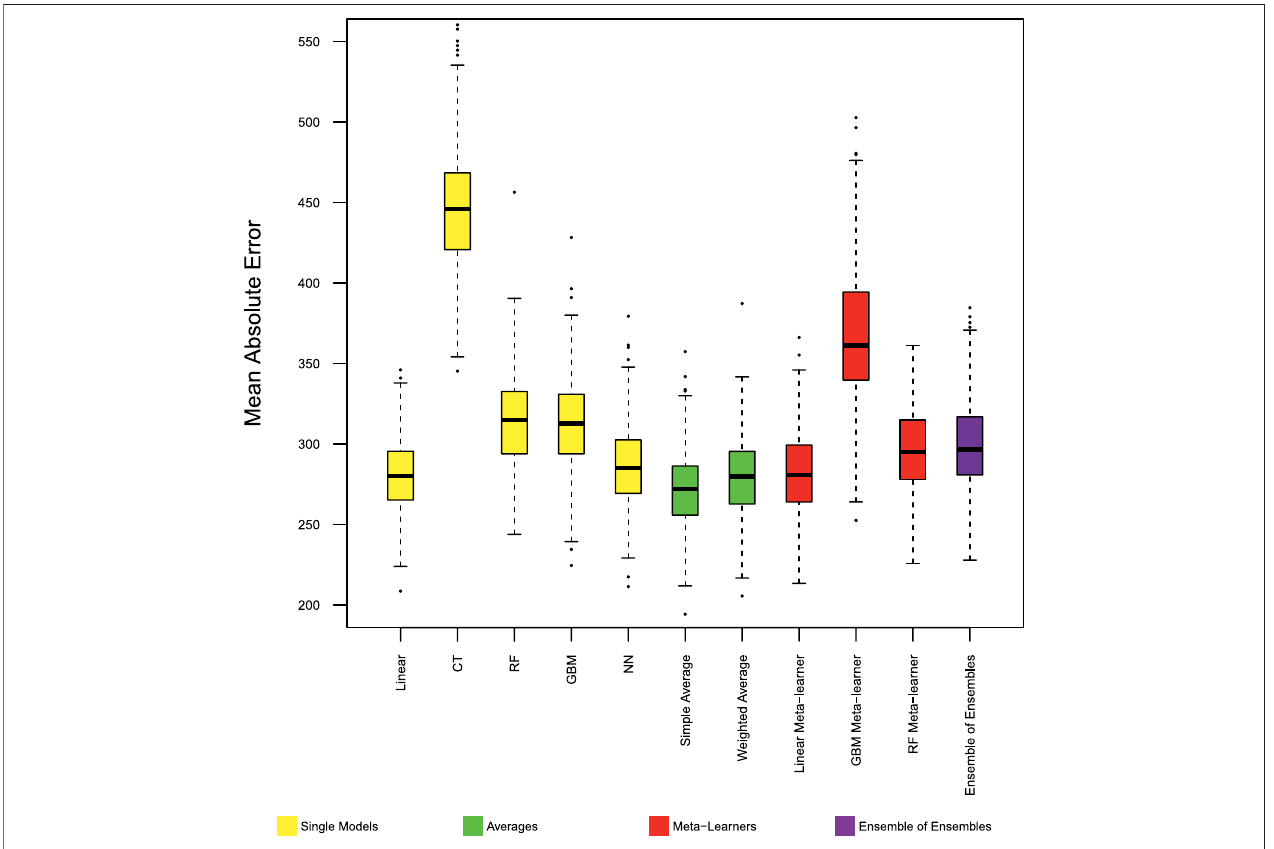
FIGURE 4 | Model performance in predicting trip production - NYC MAE. Distribution of mean absolute error from 400 experiments. Base models exclude the classi fi cation tree.